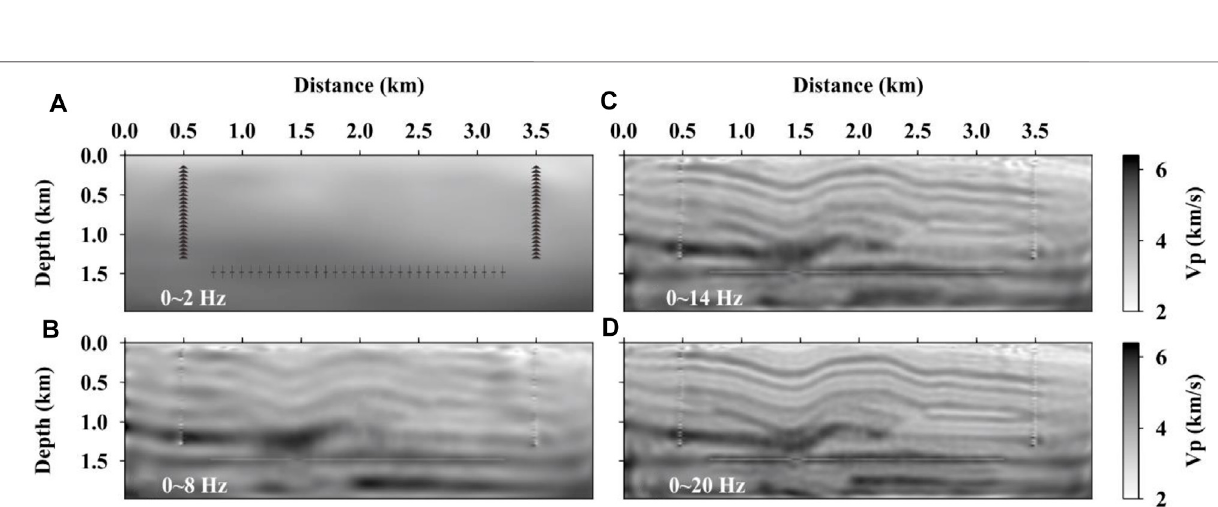
FIGURE 7 | Inversion results of the PT data. Black triangles on each side and the black cross symbols at the depth level of 1.5 km in (A) represent the receivers in theverticalobservationwellandtheperforationsinthehorizontalwell,respectively. (A – D) Iterativeinversionresultsoffrequencygroupsof0 – 2,0 – 8,0 – 14,and0 – 20 Hz,